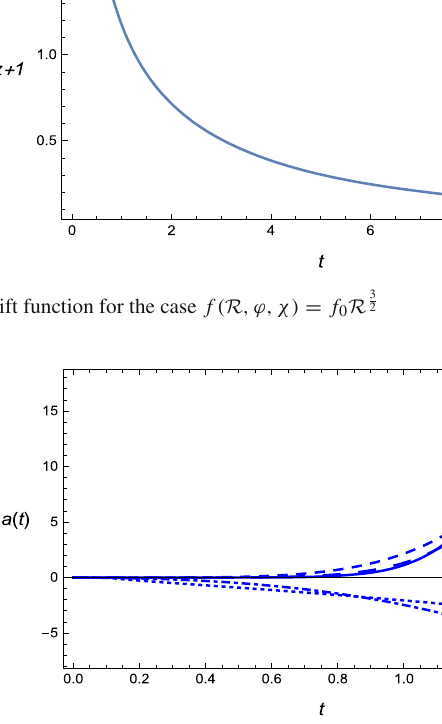
Fig. 2 Evolution of scale factor factor for f ( R ,ϕ,χ) = ϕ m R 19 14 ; m = 2 . 5(solid), m = 2(dashed), m = 1 . 5(smalldashed), m = − 0 . 125 (dotted), m = 0 . 5 (dot